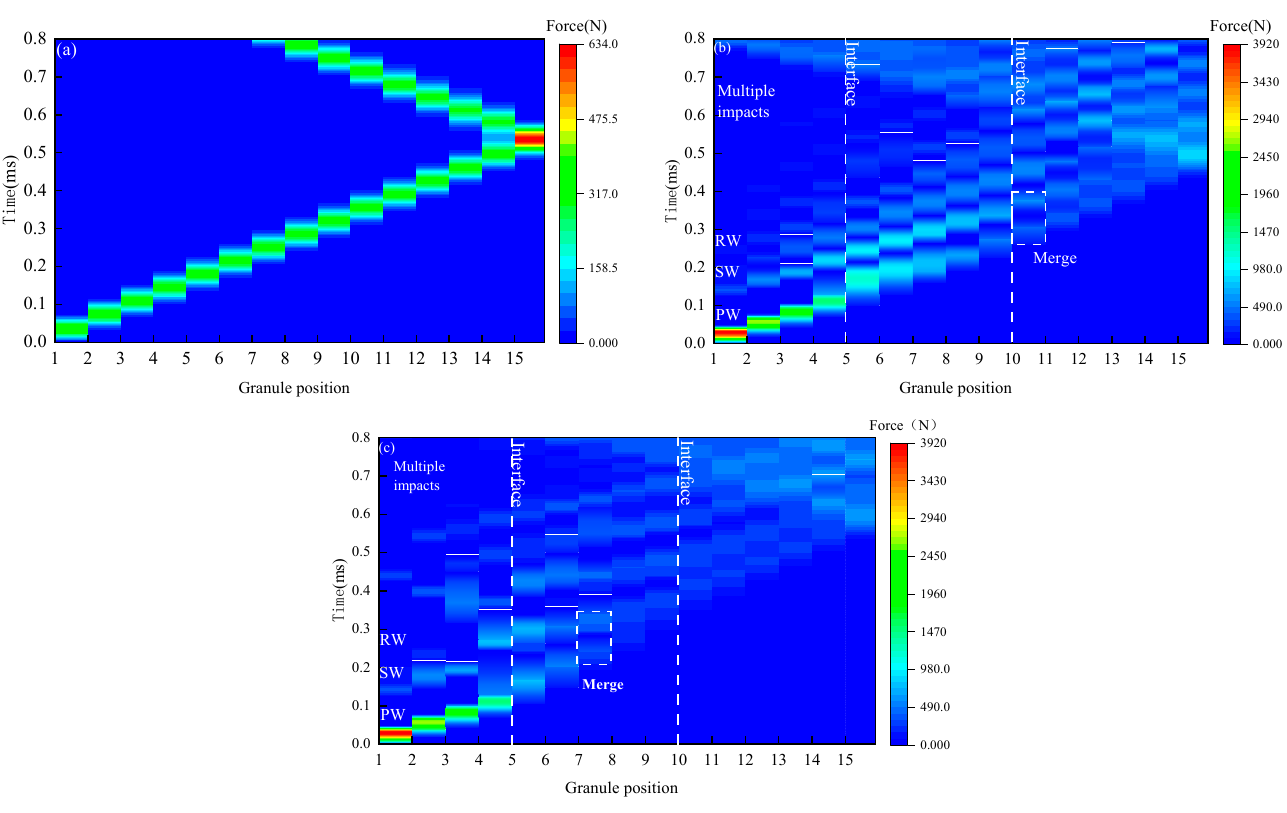
Figure 3. Comparison of impact wave propagation in elastic granular chains and elastic–plastic granular chains: ( a ) Homogeneous elastic granular chain ( V 0 = 0.45 m/s, E = 200 GPa, ν = 0.3, ρ = 7800 kg/m 3 ); ( b ) Homogeneous elastic–plastic granular chain ( λ = 1); ( c ) Heterogeneous elastic–plastic granular chain ( λ = 0.23).